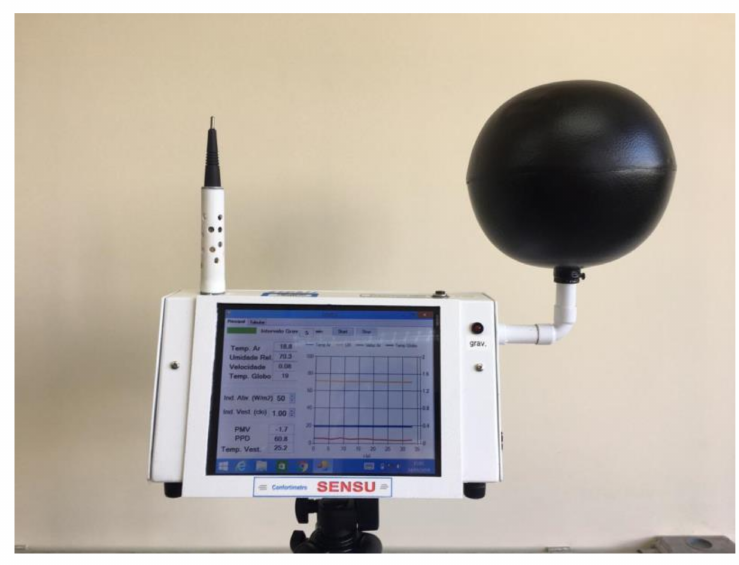
Figure 2. Microclimatic